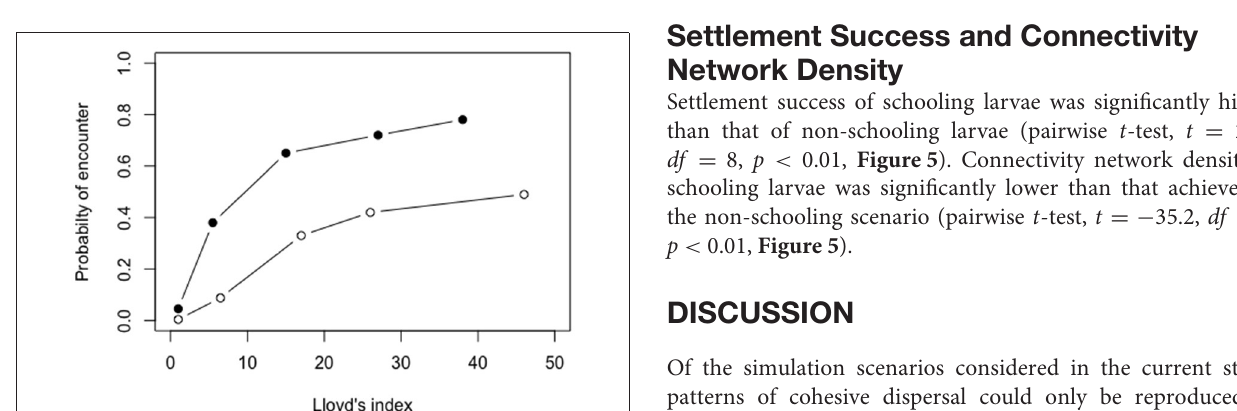
FIGURE 3 | Distances between pairs of virtual larvae that hatched at the same locations and times throughout the pelagic larval duration (PLD) for the following strategies: passive, simple random walk (SRW), auto-correlated directional swimming (CRW), ontogenetic vertical migration (OVM), biased correlated random walk (BCRW), and schooling behavior (simulation #3–8, Table 1 ). Shaded areas indicate 99% confidence intervals ( N = 32,046 and 28,414 for the passive and other strategies respectively).